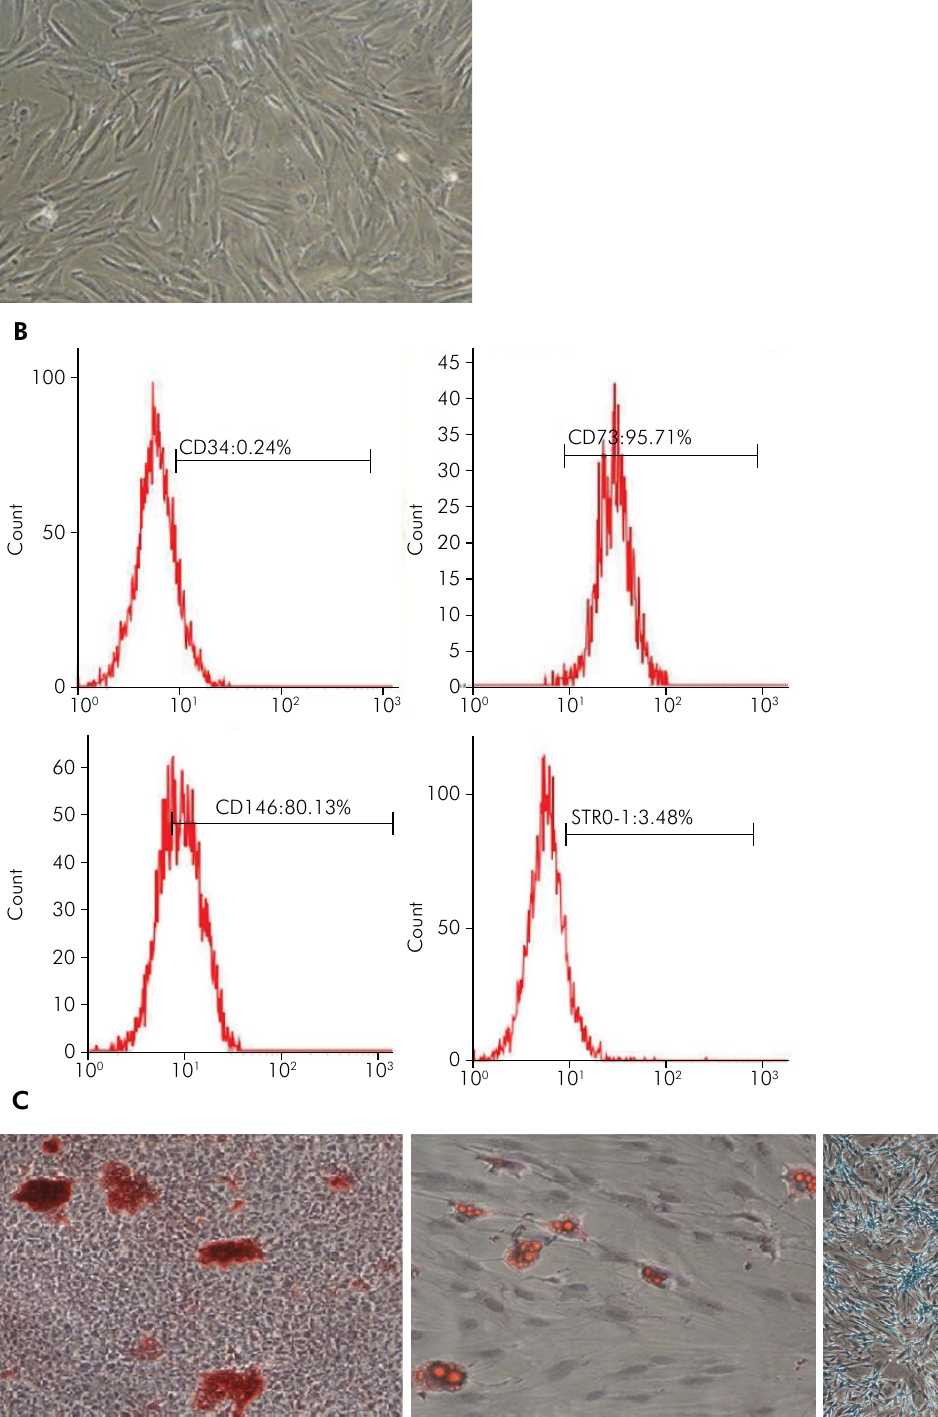
Figure 1. A: Morphological characteristics of DFCs at the third passage were observed under a light-inverted microscope. DFCs exhibit typical fibroblast-like spindle morphology. B: Flow cytometric analysis indicated that the DFCs were of mesenchymal origin (positive for CD73 and negative for CD34) and that the DFCs were stem cells (positive for CD146 and STRO-1). C: Osteogenic (Os), adipogenic (Ad) and chondrogenic (Ch) differentiation of